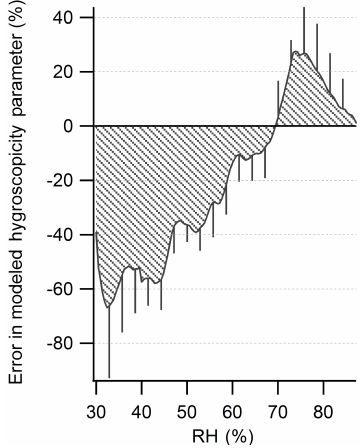
Figure 5. Average error in predicted WSM κ (RH). Error is defined as ( κ( RH ) predicted − κ( RH ) measured )/κ( RH ) measured . Whiskers de- pict the standard deviation of error among the five